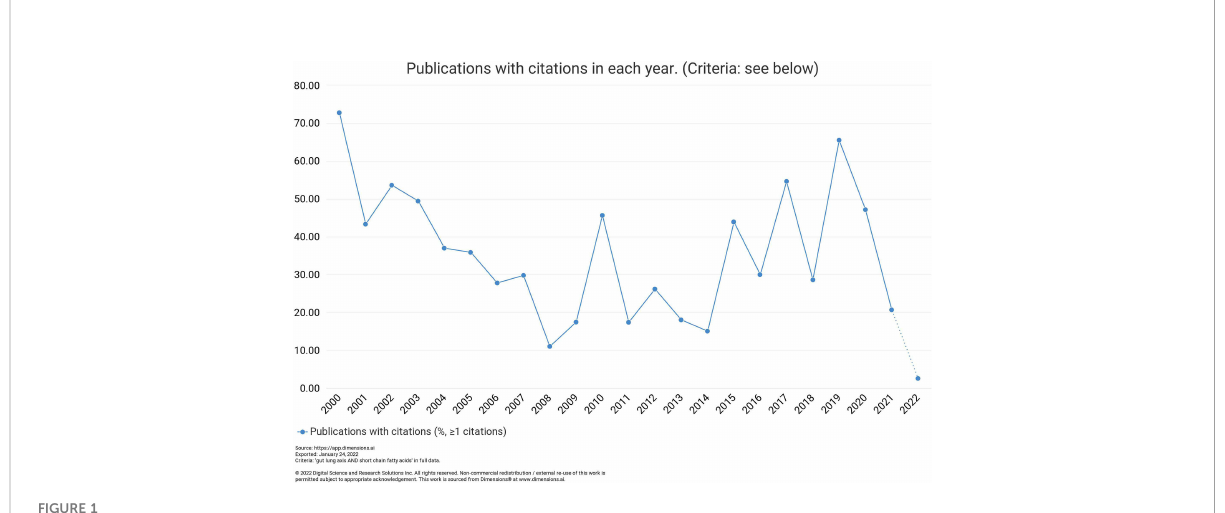
FIGURE 1 Year-wise trend in the publication for the last 20 years (2003 –